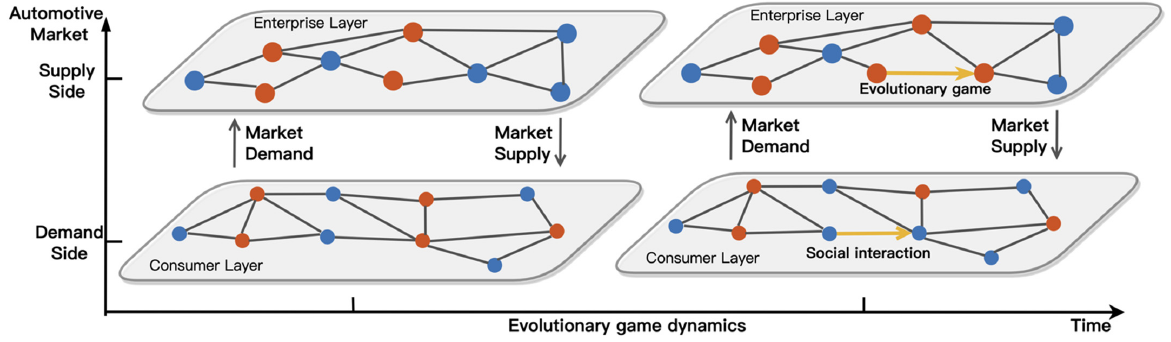
Figure 2. Schematic diagram of the network-based evolutionary dynamics for EV diffusion. The red and blue colors represent manufacturers or consumers who choose different strategies.